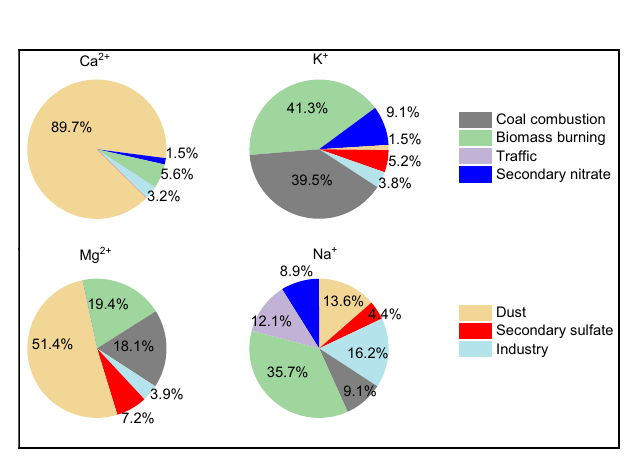
Fig. 5 | The sources of soluble alkali metals in PM 2.5 . The relative mean con- tribution from coal combustion, biomass burning, traf fi c, secondary nitrate, dust, secondary sulfate and industry sources to the mass concentrations of Ca 2+ , Mg 2+ , K + and Na + ions.